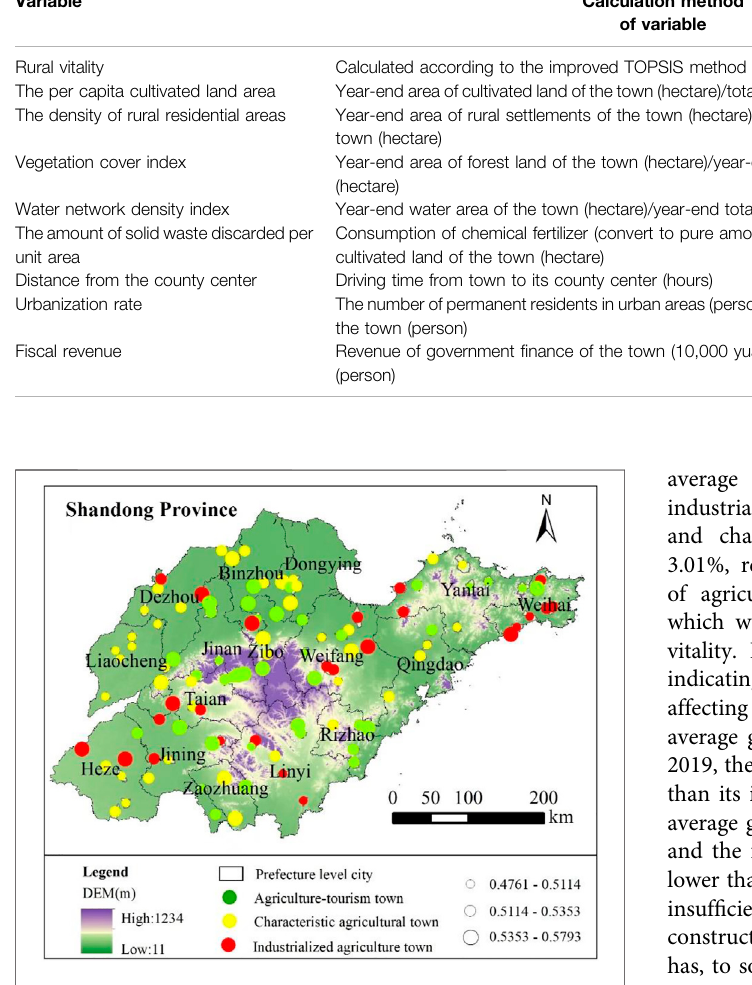
FIGURE 7 | Comprehensive vitality value of different village types in